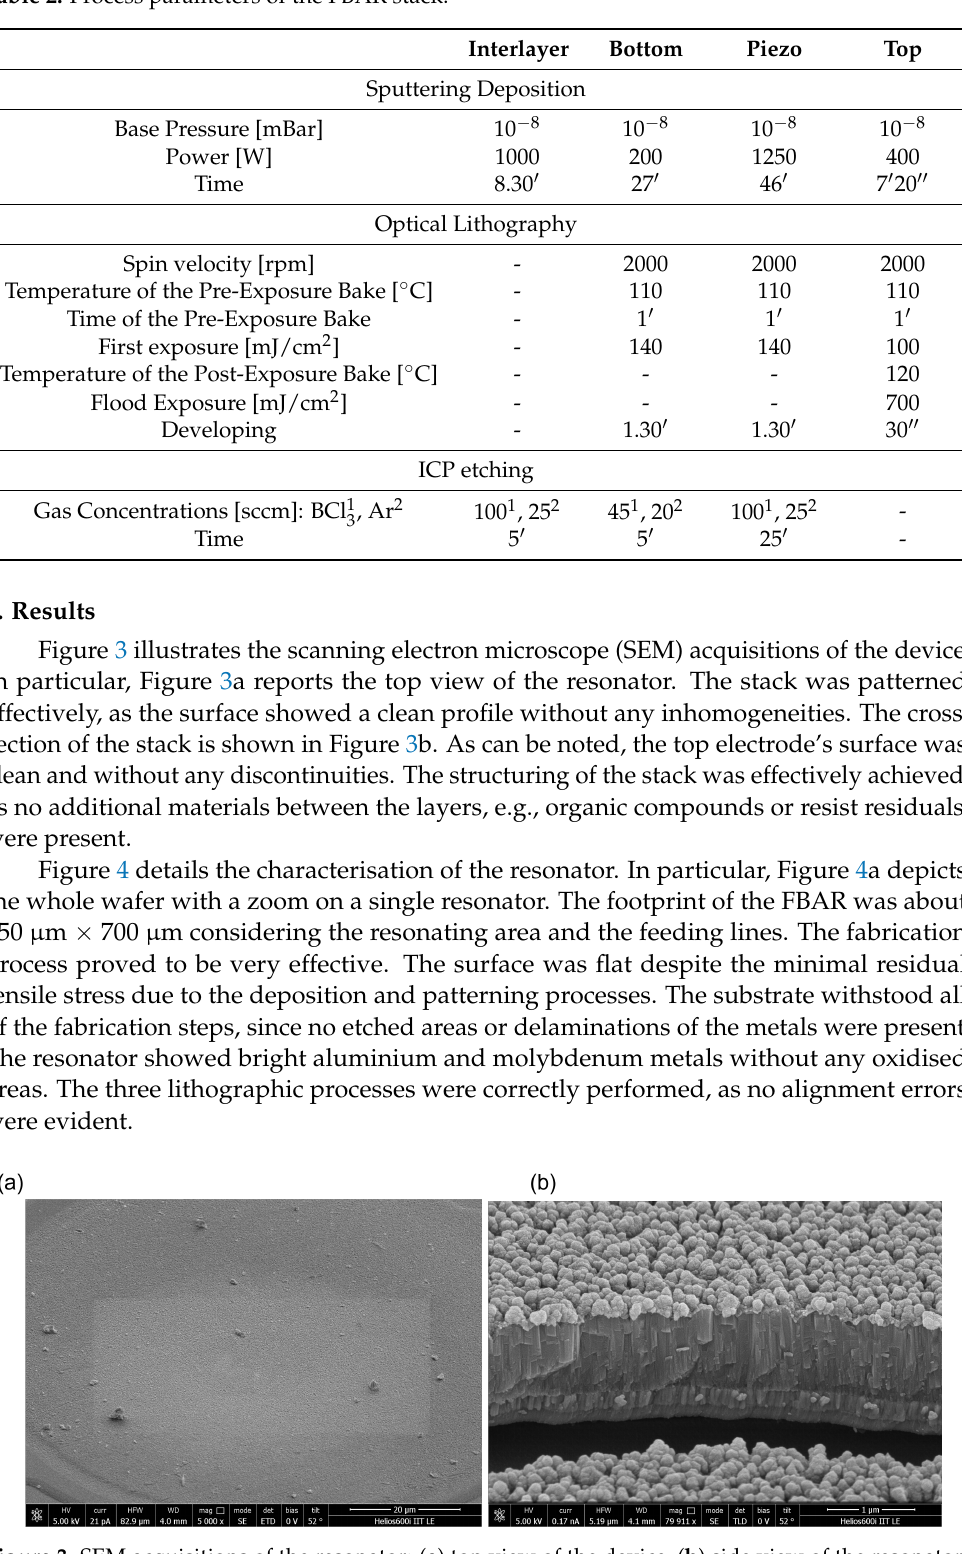
Table 2. Process parameters of the FBAR stack.